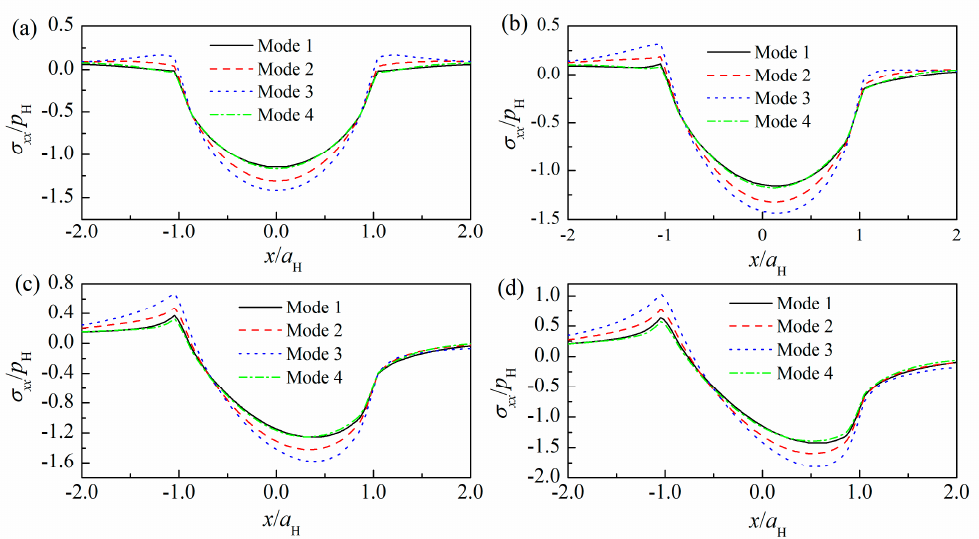
Figure 7. The stress σ xx along x axis of multilayered system with different elasticity modulus changing modes under various friction coefficients, ( a ) μ f = 0, ( b ) μ f = 0.1, ( c ) μ f = 0.3, ( d ) μ f = 0.5.